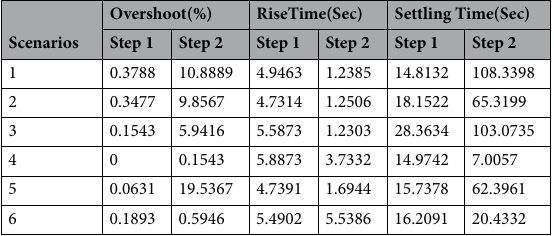
Table 10. BELBIC performance comparison for different scenarios.